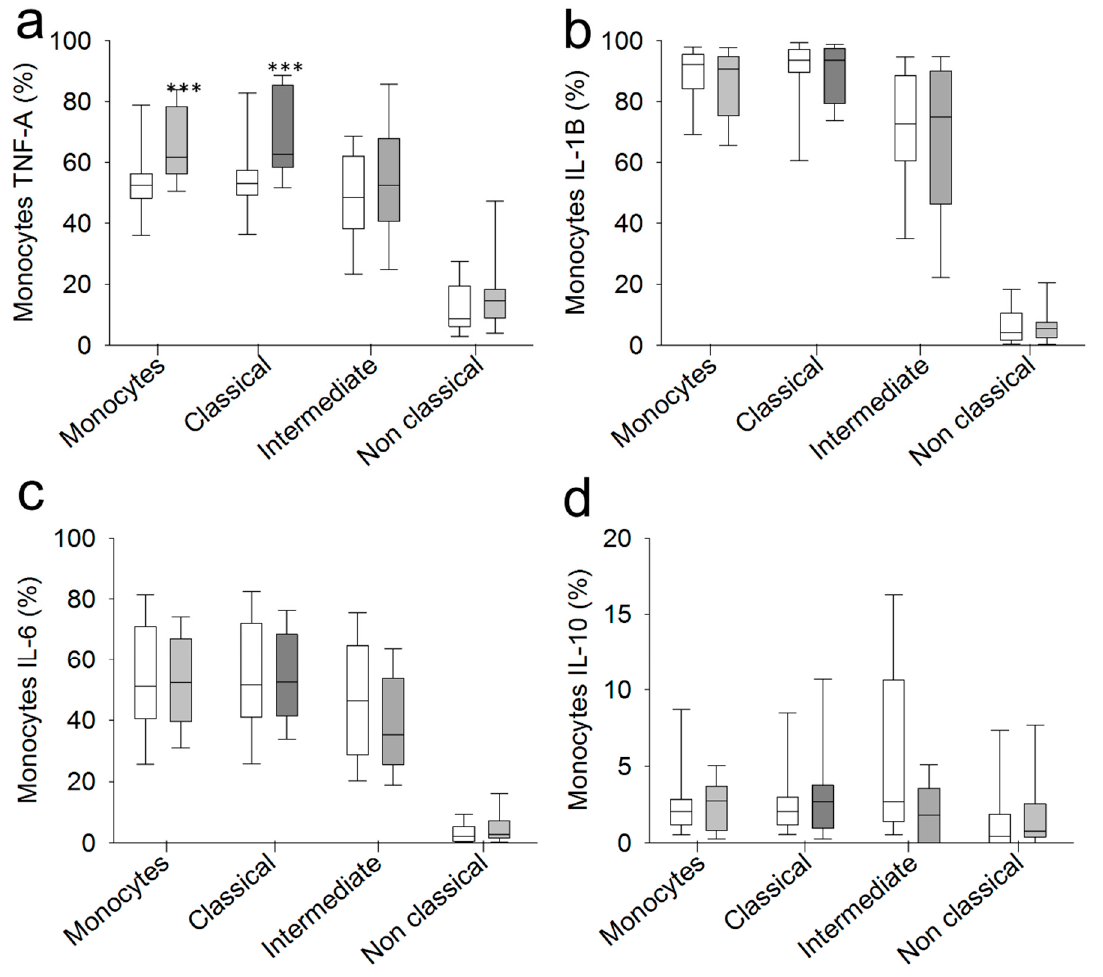
Figure 3. Cytokine production by circulating monocytes from chronic SCI patients. Percentages of monocytes producing TNF- α : ( a ) IL-1 β ; ( b ) IL-6; ( c ) and IL-10 ( d ) among circulating monocytes and the CD14 +high CD16 − , CD14 +high CD16 + and CD14 +low CD16 + monocyte subsets from chronic SCI patients (gray box) and healthy controls (white box). *** Significant difference between patients and healthy controls ( p < 0.001).